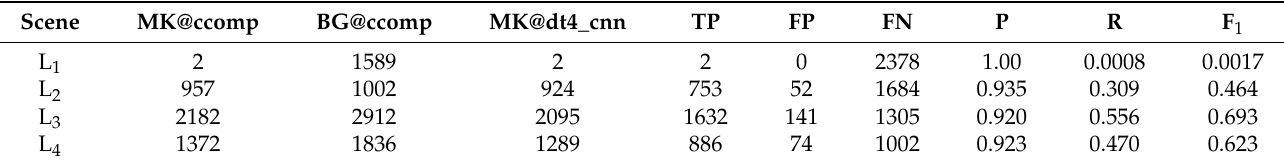
Table 4. Evaluation of the proposed system without low-illumination image enhancement.